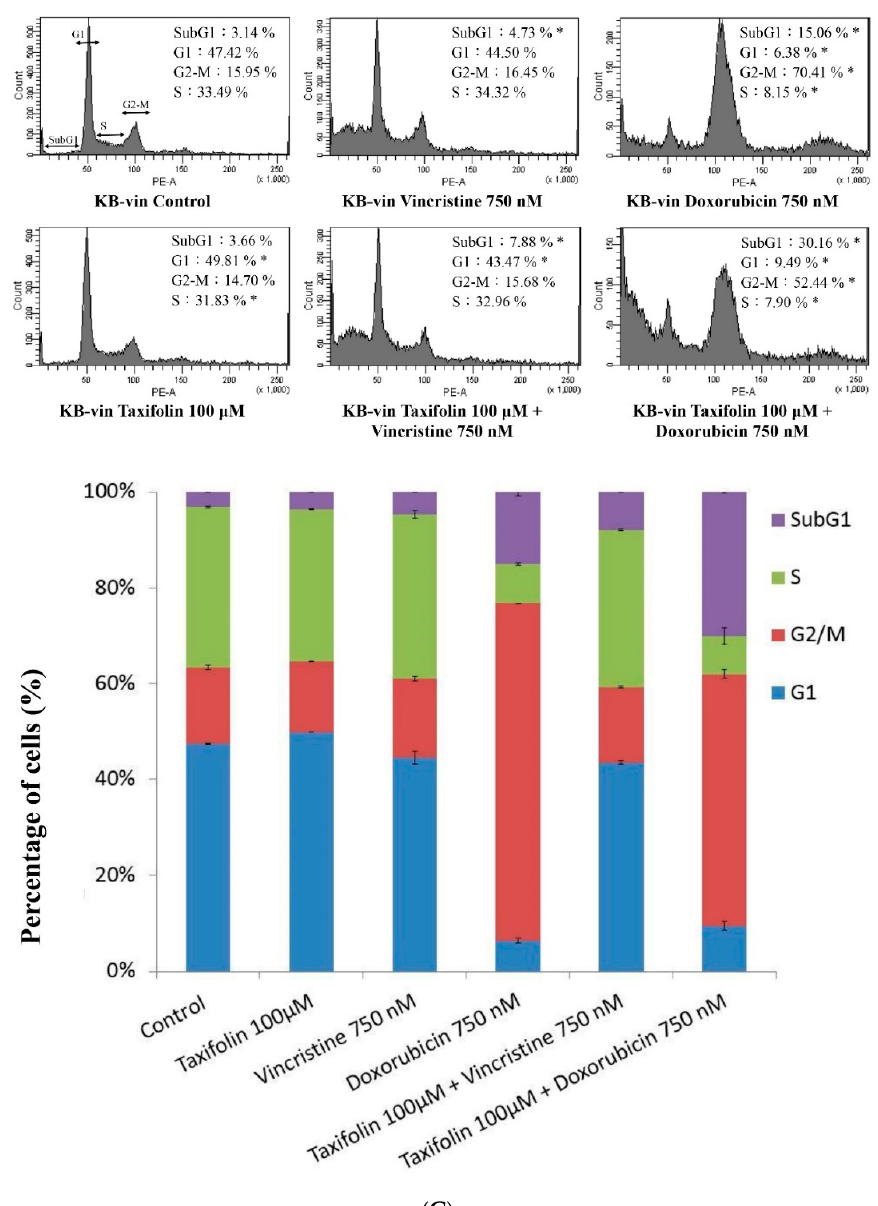
Figure 4. Effect of Taxifolin on P-gp mRNA expression and cell cycle analysis in HeLaS3 and KB-vin cells. Cells were treated with indicated concentration of compounds for 72 h. ( A ) ABCB1 mRNA expression levels were significantly downregulated by taxifolin treatment in MDR KB-vin cancer cell line. ( B , C ) Combination of taxifolin with doxorubicin or vincristine increased levels of apoptosis (subG1) in HeLaS3 and KB-vin cells. Data presented as mean ± SE of at least two experiments, * denotes p < 0.05 compared with control group.